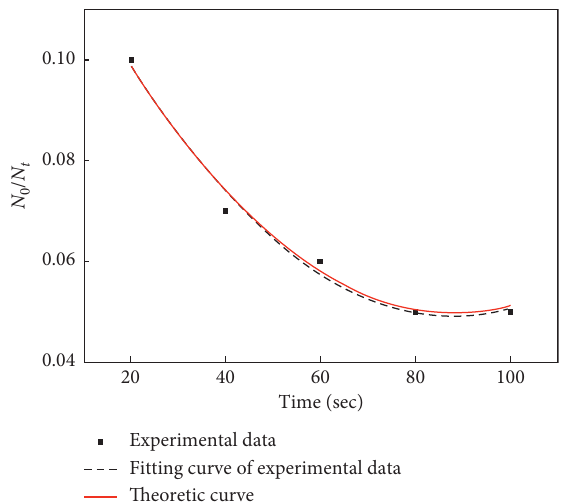
Figure 6: Kinetic curves of flocculation processes for diatomite suspension with